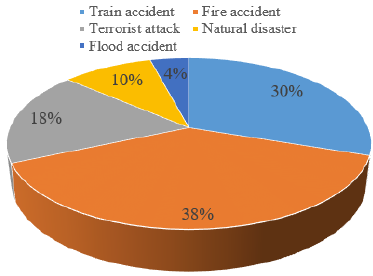
Figure 1. Statistics of subway